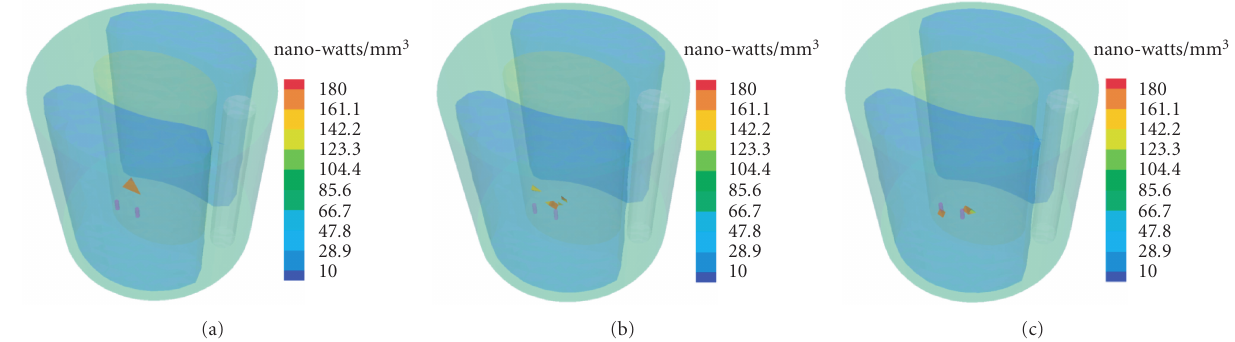
Figure 5: Comparison between the actual and reconstructed sources. (a) The BLT reconstruction without anatomical and optical informa- tion; (b) the counterpart only with anatomical information; and (c) that with anatomical and optical